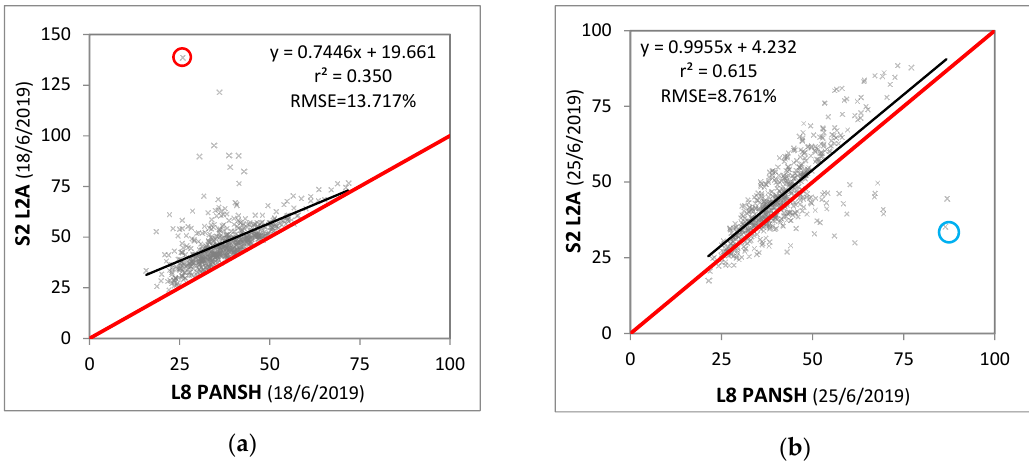
Figure 10. Scatterplots relating pairs (S2 L2A vs. L8 PANSH) of surface reflectance values for all the common six bands over the 100 polygons in SS1 considering two dates: ( a ) 18 June 2019; ( b ) 25 June 2019. The data highlighted with the red and blue circles are matched with those shown in Figure 9 for SWIR2.